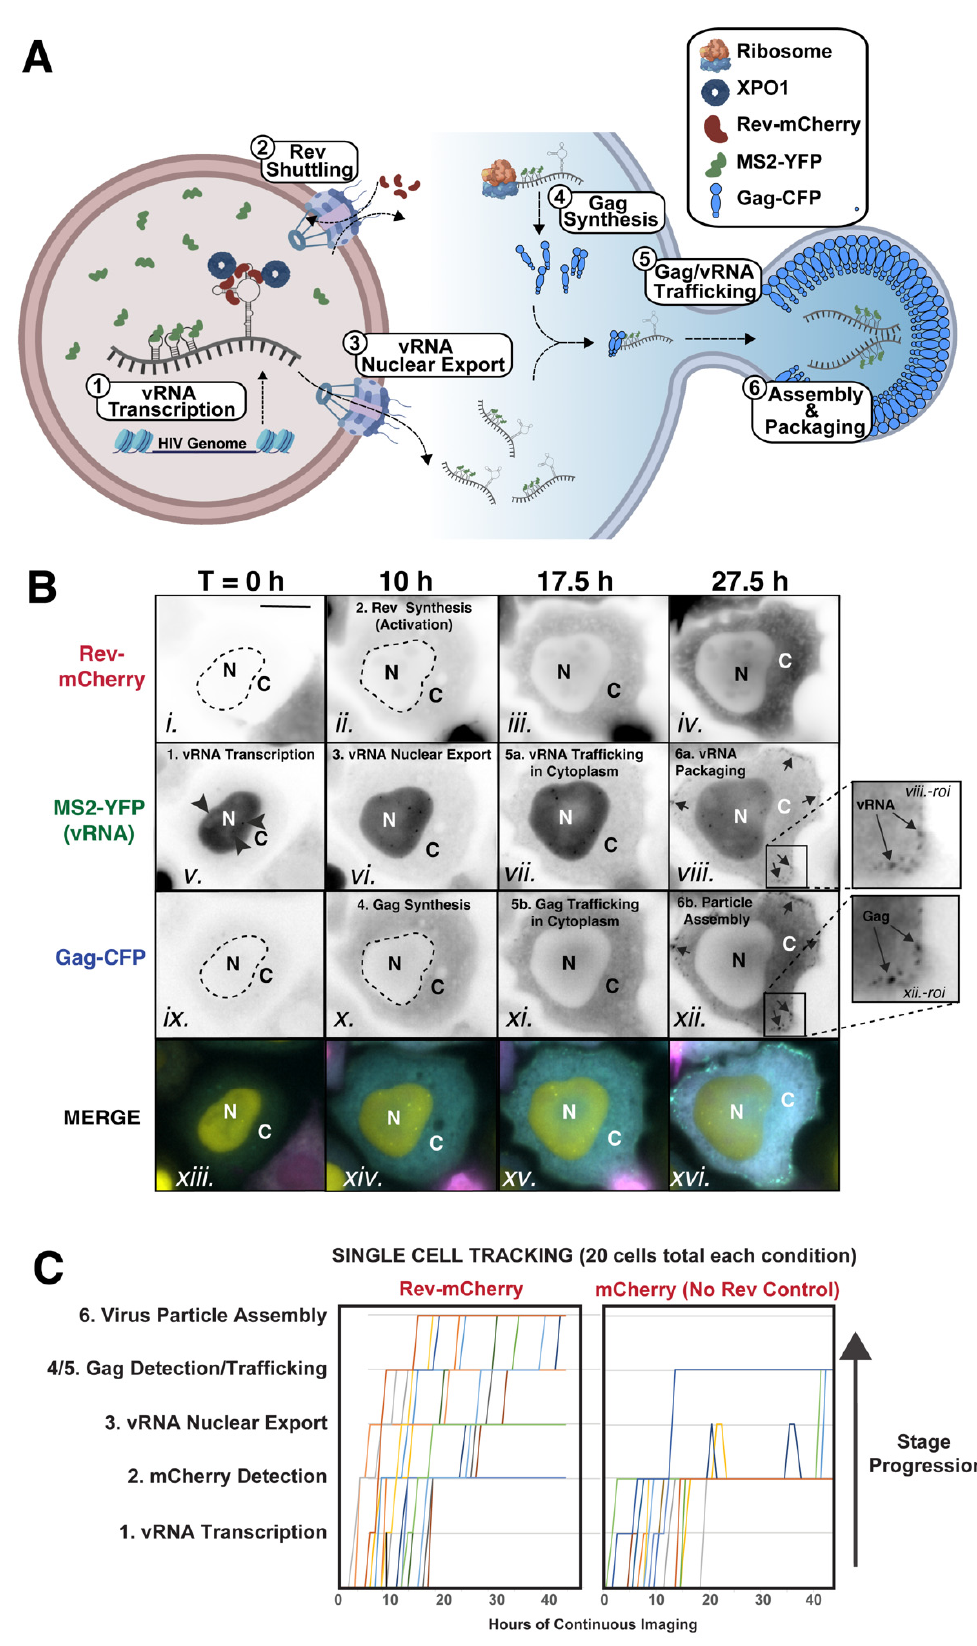
Figure 1. HIV RGB: multicolor single-cell tracking of HIV-1’s post-transcriptional stages. ( A ) Scheme of HIV RGB strategy, wherein nascent vRNA transcripts are visualized in the nucleus using